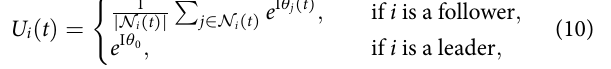
Frontiers in Robotics and AI |